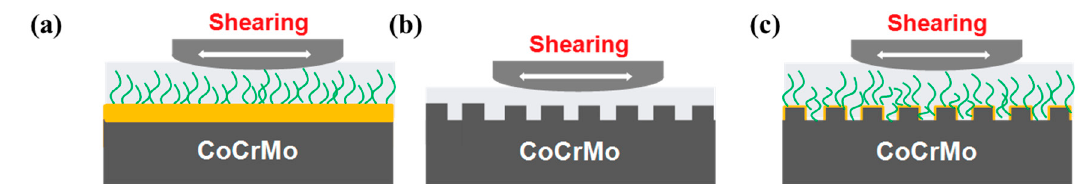
Figure 10. Schematics of the contact mechanics for ( a ) polymer brushes grafted on a flat CoCrMo surface, ( b ) a textured surface, and ( c ) thicker polymer brushes on a textured surface.